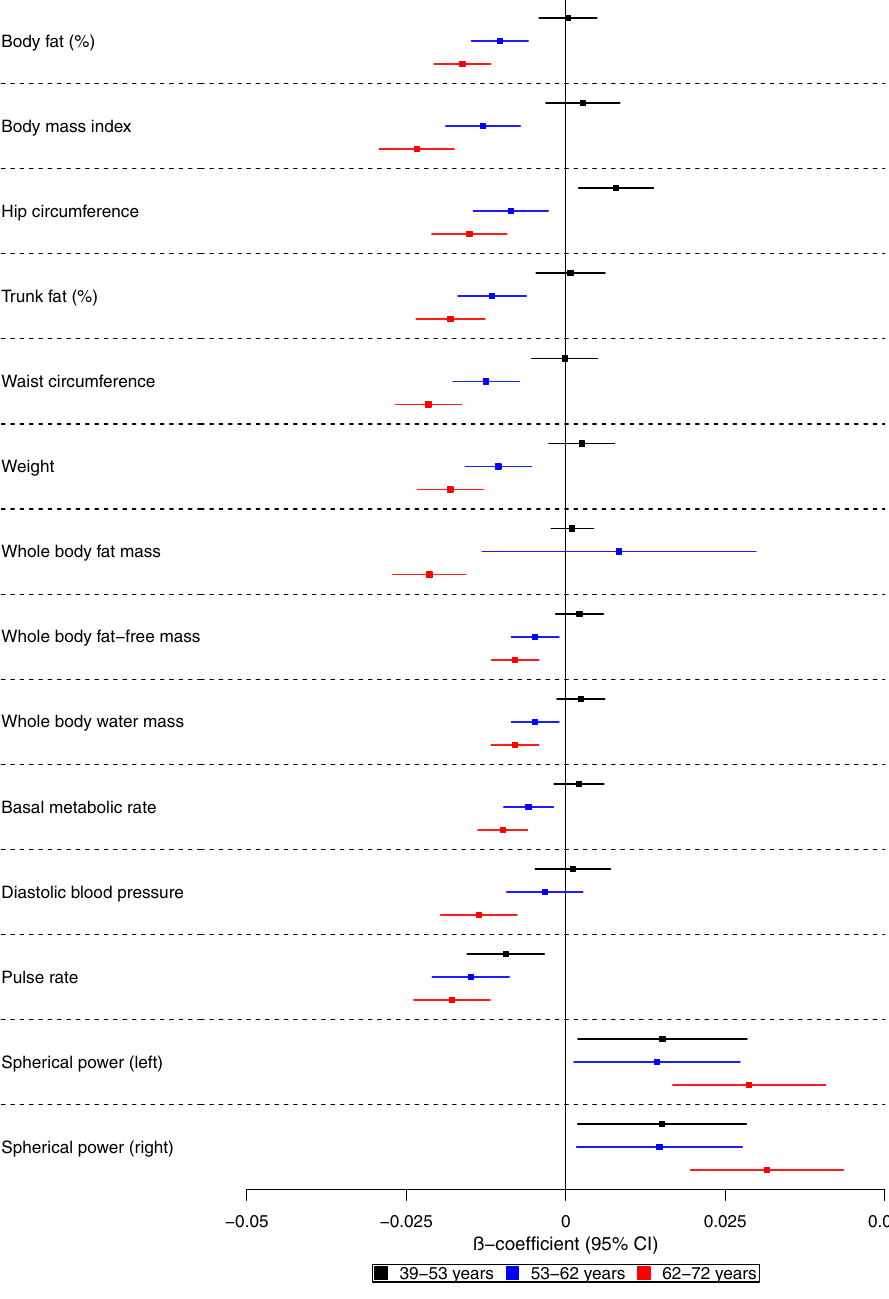
Fig.2|Forestplotshowingtheeffectestimatesfortheassociationbetweenthe polygenic risk score for Alzheimer ’ s disease (including the APOE region) and physicalmeasures. Legendsatthebottomofeachgraphindicateagetertiles.Each tertileconsistsof111,656participants,orderedbyage.Effectestimatesrepresentan SD change in the phenotype per 1 unit increase in the standardized polygenic risk